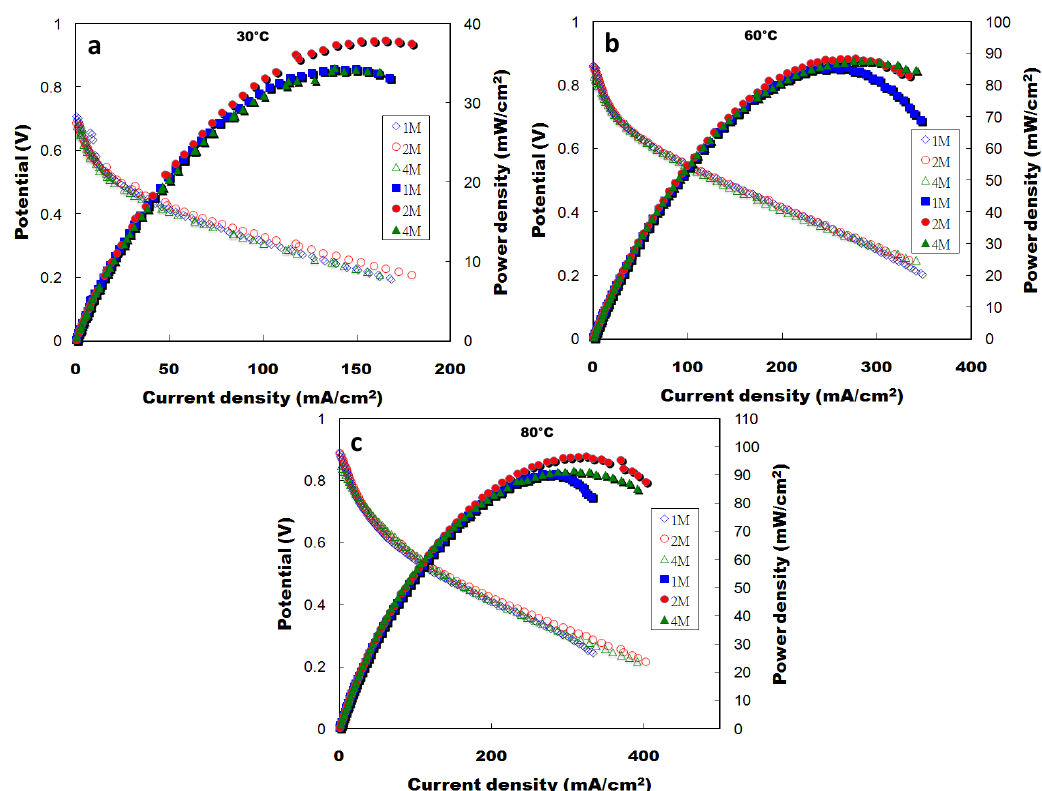
Figure 11. Methanol cell performance of QPVA/5%FS nanocomposite membranes at ( a ) 30; ( b ) 60 and ( c ) 80 °C with 6 M KOH.